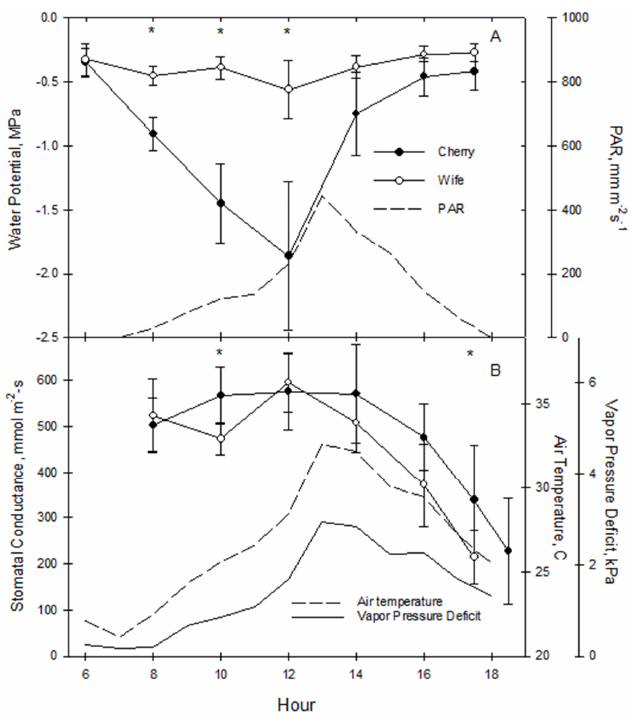
Figure 1. Dawn-to-dusk stomatal conductance (A) and leaf water potential (B) for two industrial hemp cultivars, ‘Cherry’ and ‘Wife’, on 19 February 2020, plus standard deviation ( n = 8), Also shown are atmospheric variables photosynthetically active radiation (PAR), air temperature, and vapor pressure de fi cit. Hourly data points with asterisks indicate signi fi cant di ff erences between cultivars at p < 0.05.